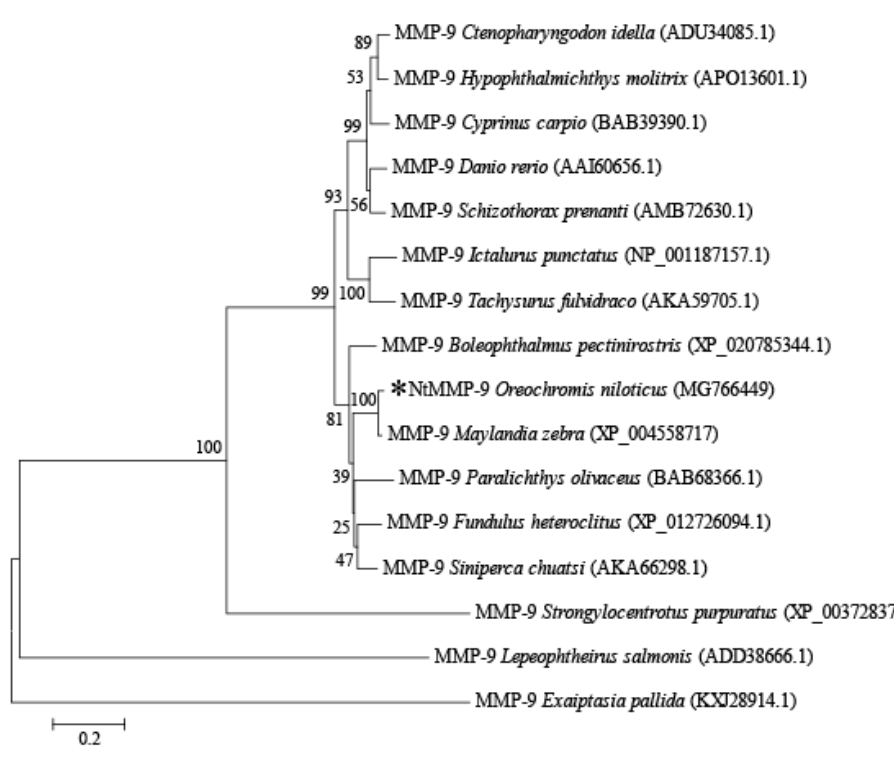
Figure 2. Phylogenetic tree of MMP-9s constructed from different species. Bootstrap values are 1000; and NtMMP-9 is marked with a black star.